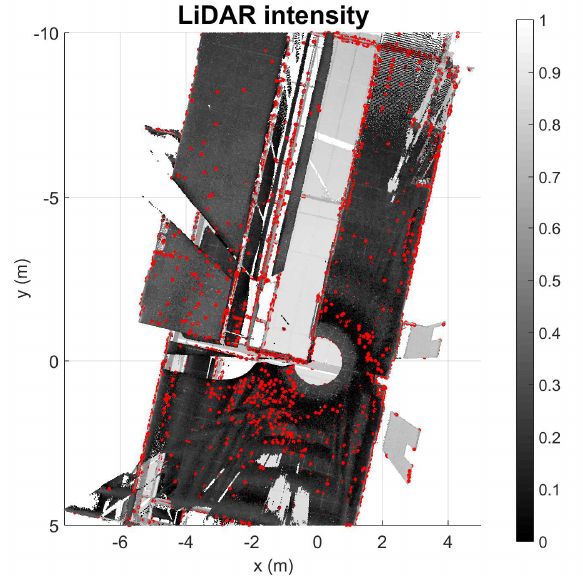
Figure 4. Keypoints (red) from LiDAR return intensities detail.